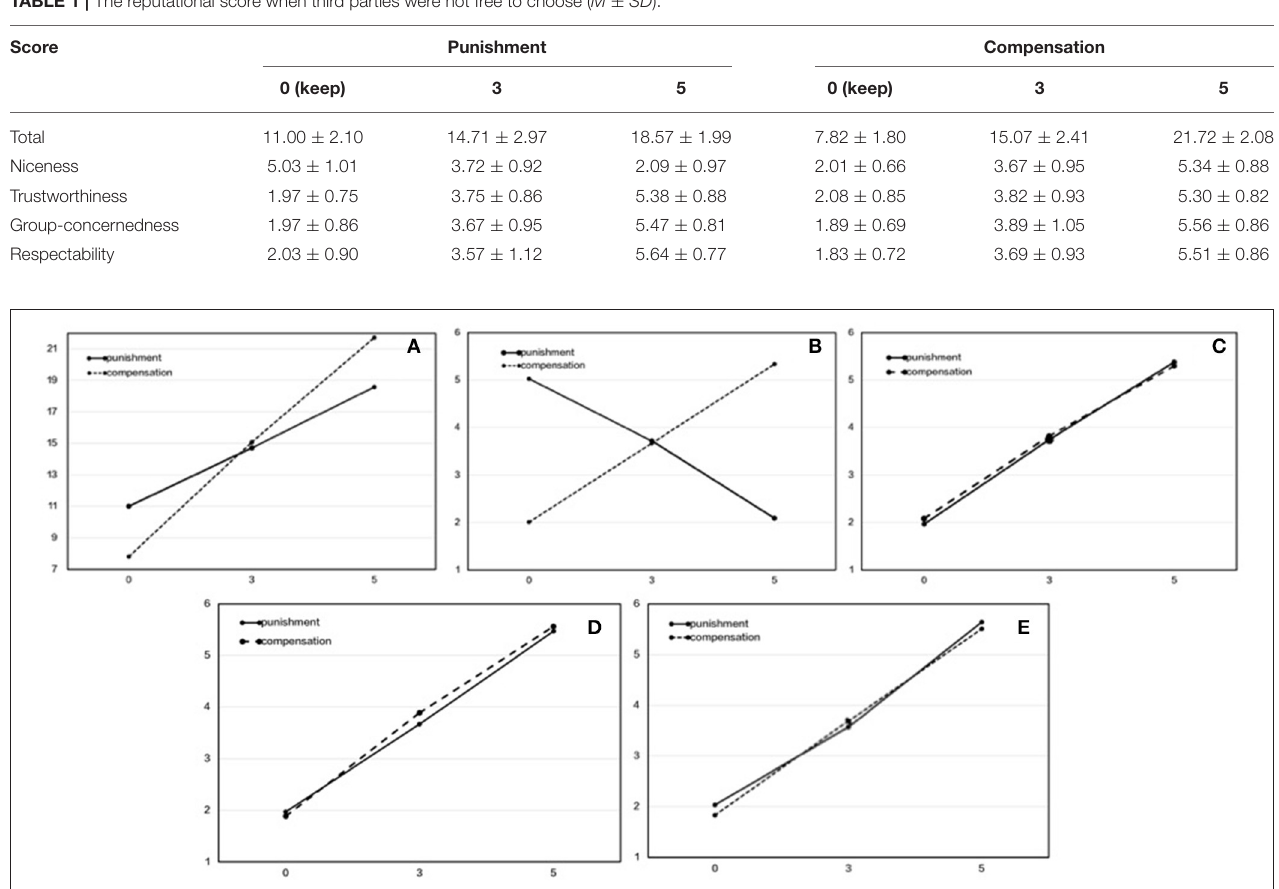
M ± SD = 19.19 ± 1.41). The study was approved by the academic ethics committee of Shanghai Dianji University.